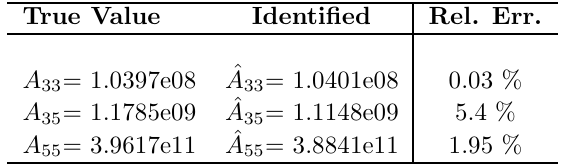
Table 2: True and Identified Added Mass